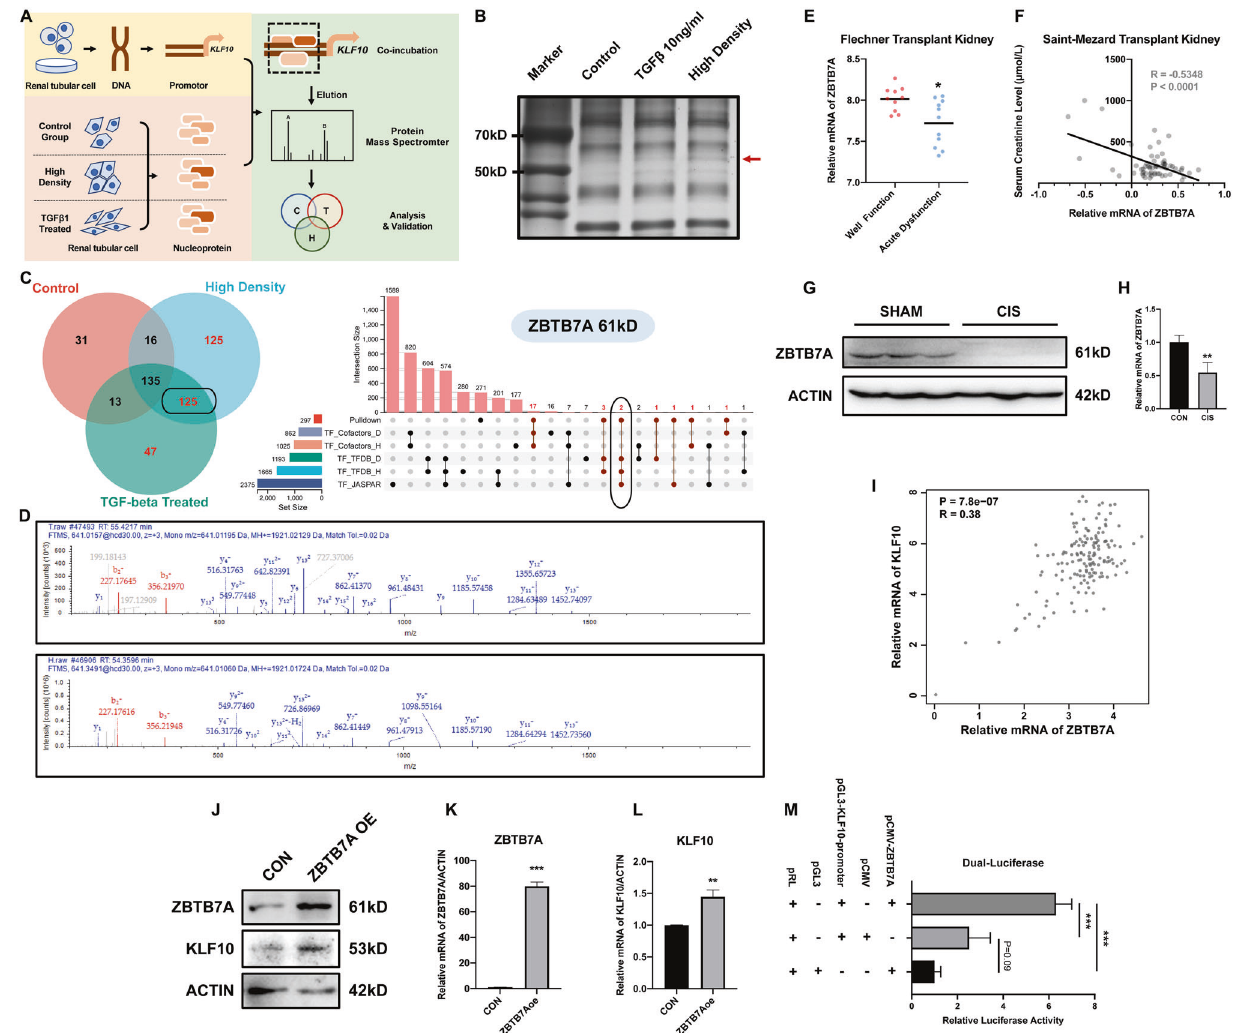
Fig. 8 ZBTB7A promoted KLF10 expression by combining to the promotor regions of KLF10. A Flowchart detailing extraction and analyses of transcription factors combining KLF10 promoter in C57BL/6 J mice. B Silver staining SDS-PAGE gel of nucleoprotein precipitated with promoter of KLF10. C Venn plot of precipitated proteins in high-density, TGF β 1 treated group and control group. UpSetR plot of common transcription factors database and proteins only in high-density and TGF β 1 treated group not in control group (marked in red in Venn plot). D Protein mass spectrometer of ZBTB7A in high-density/TGF β 1 treated group and not detected in control group. E Scatter plot of relative expression of KLF10 in normal function group versus dysfunction group in Flechner database. F Negative correlation between ZBTB7A and SCr in Saint-Mezard database. G , H Representative immunoblot analysis and relative mRNA levels of ZBTB7A in cisplatin-induced AKI group and control group. ACTIN served as the standard. n = 6 per group. I Positive correlation between KLF10 and ZBTB7A in TCGA and GTEx normal kidney tissue database. J – L Representative immunoblot analysis and relative mRNA levels of ZBTB7A and KLF10 in ZBTB7A overexpressed group and control group. M Luciferase activity quanti fi ed in 293 T cells of interaction between ZBTB7A and KLF10 promoter. * p < 0.05, ** p < 0.01, *** p < 0.001 vs control group at the same experimental